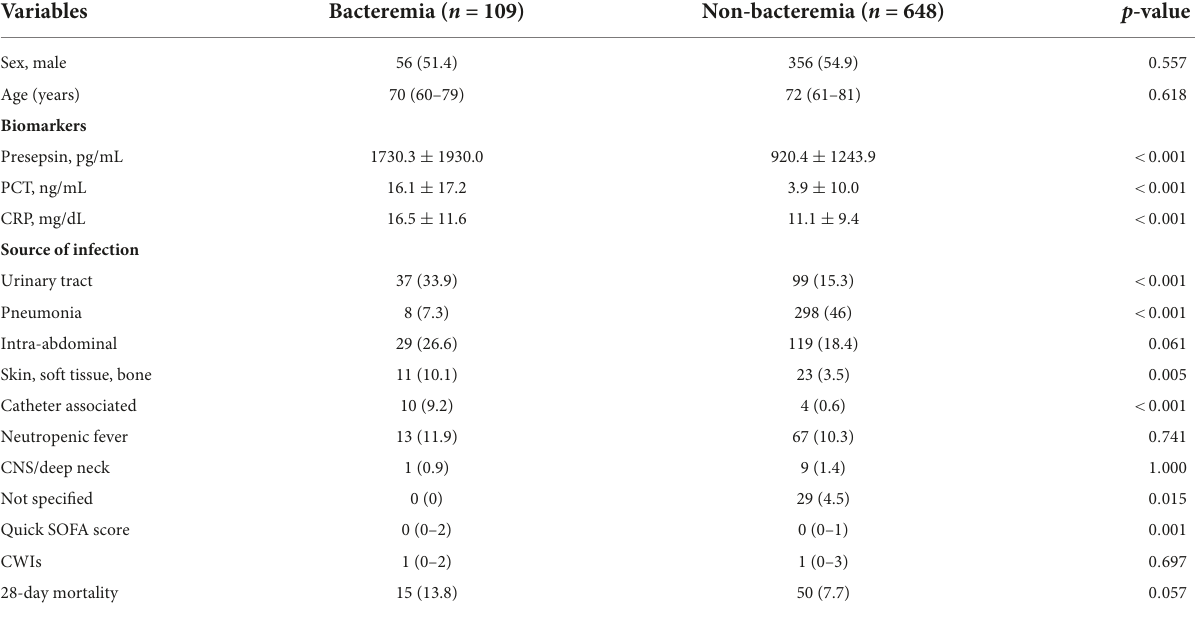
TABLE 1 Patient demographic and clinical